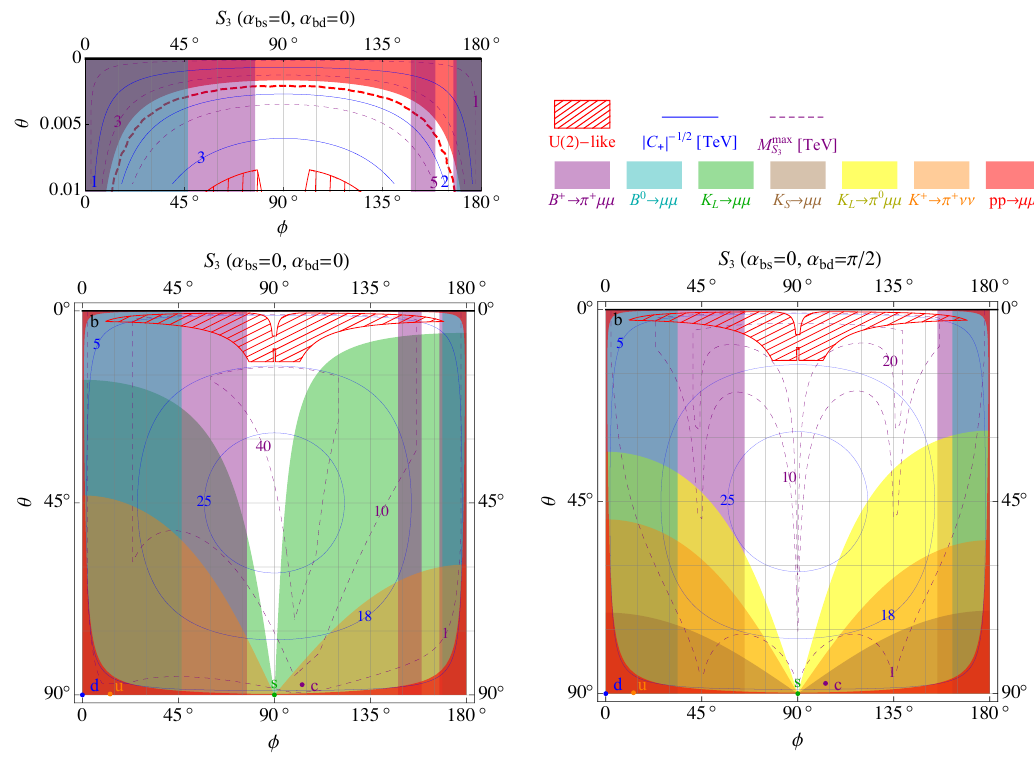
Figure 2 . Limits in the plane ( (cid:30); (cid:18) ) for the scalar leptoquark S 3 and two choices of the phases (cid:11) bs and (cid:11) bd . In addition to the limits in (cid:12)gure 1, the orange bound is from K ! (cid:25)(cid:23)(cid:23) while the red one is from the high- p T tail of pp ! (cid:22) + (cid:22) (cid:0) at the LHC [63]. The top-left panel is a zoom of the region (cid:18) (cid:28) 10 of the bottom-left one, which shows in more detail the region excluded by LHC dimuon searches. The dashed purple contour lines are the upper limits (in TeV) on the leptoquark mass from (cid:1) F = 2